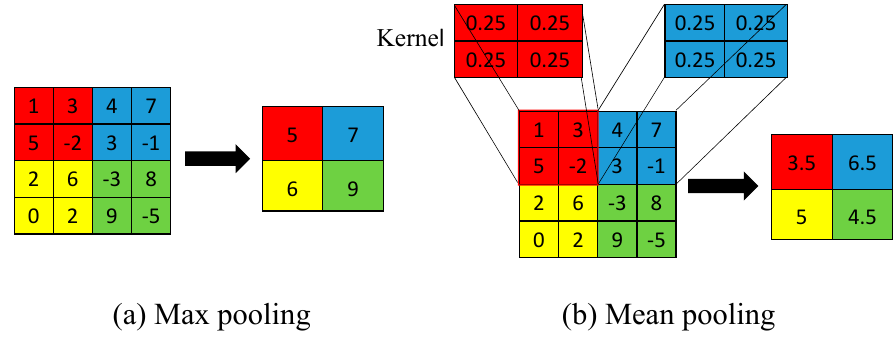
Figure A2. Pooling Figure A2. Pooling process. Figure A2. Pooling process.